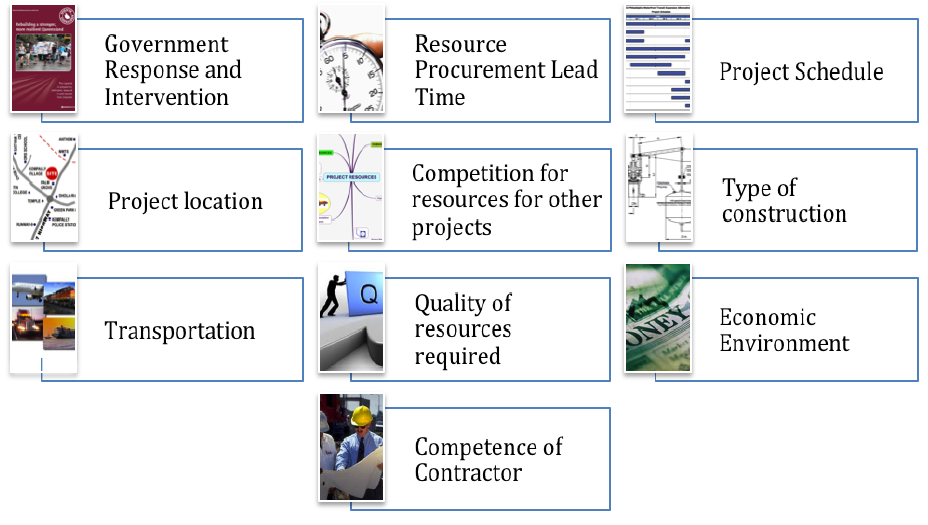
Figure 2 Factors affecting resourcing in a post disaster project (Chang, et al. 2012,